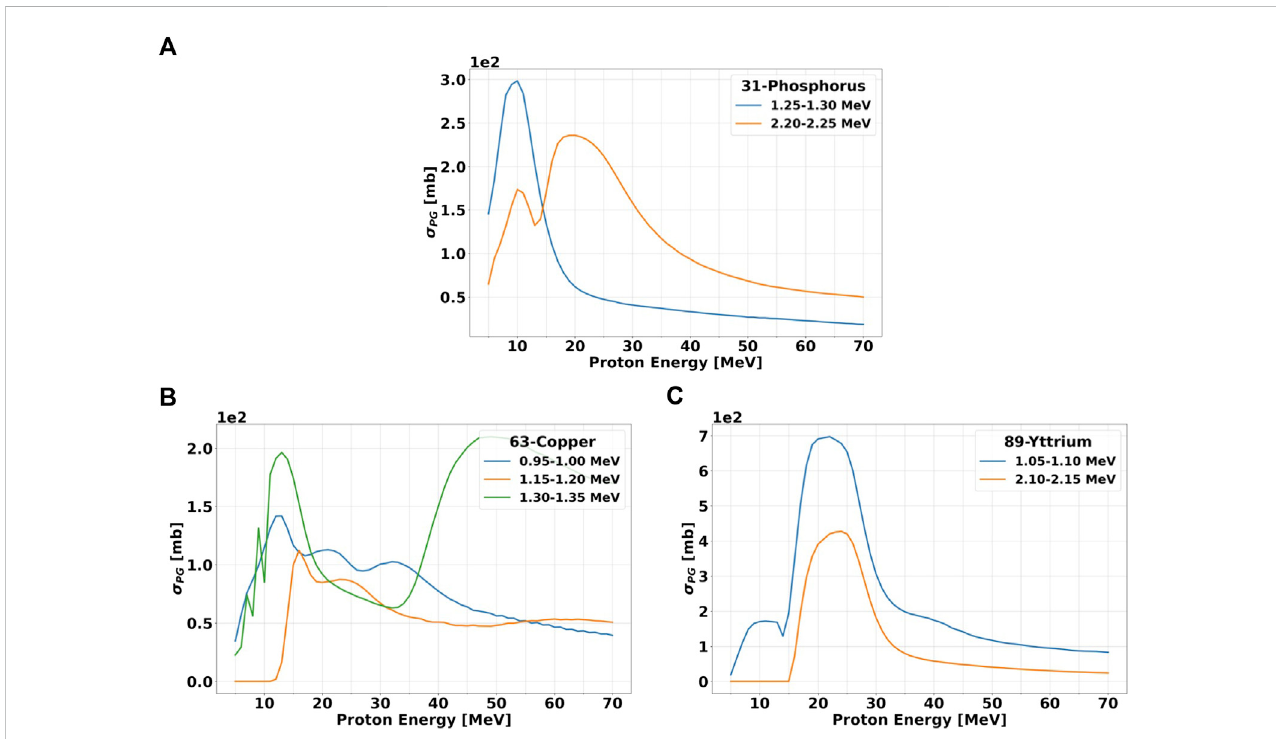
FIGURE 6 Production cross section σ PG versus incident proton energy for gammas of selected energies. The data are shown for the three candidate elements: 31 P (A) 63 Cu (B) and 89 Y (C) . The proton energy step is set to 1 MeV. The gamma energy range over which the cross sections have been evaluated is the same as Figures 5B – F and it is speci fi ed in the legend. All calculations have been performed with